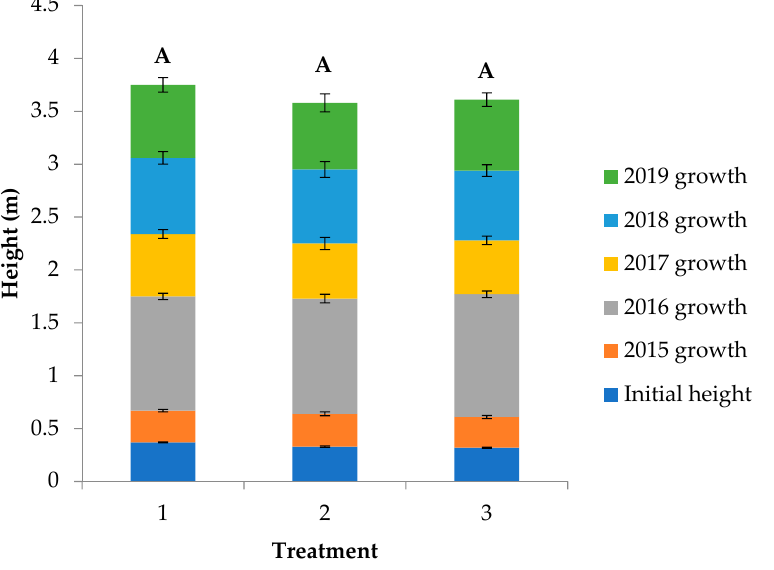
Figure 4. Mean initial height and mean annual height increment ( ± SE) (year 1 = 2015 growth; year 2 = 2016 growth; year 3 = 2017 growth; year 4 = 2018 growth; year 5 = 2019 growth) (m) ( ± SE) for balsam poplar trees planted in three treatments (1 = 25 selected tolerant clones, 2 = 10 selected control clones, 3 = Stream 1 veg. lot clones). Significant differences between treatment means for height are indicated by different letters at p ≤ 0.05.